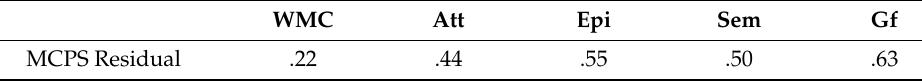
Table 4. Latent factor correlations between working memory capacity (WMC), attention control (Att), episodic memory (Epi), semantic memory (Sem), crystallized intelligence (Gc), fluid intelligence (Gf), and multiply-constrained problem solving residual (MCPS Residual).